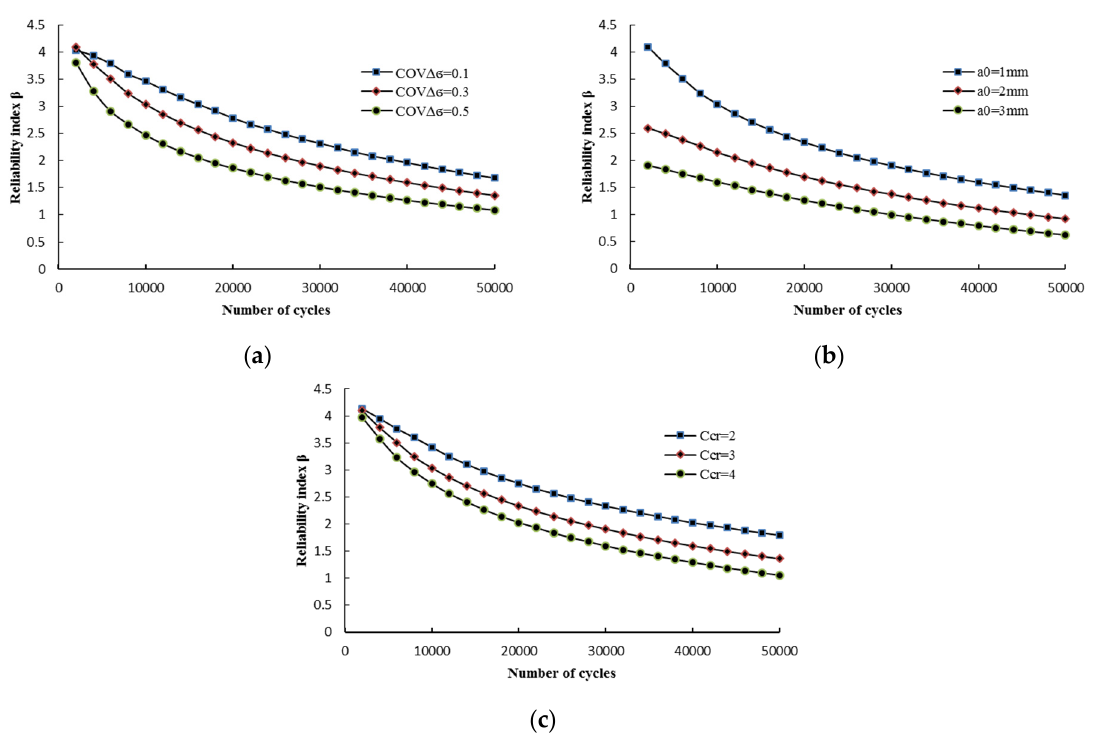
Figure 8. Effect of ( a ) uncertainty of stress range ( b ) initial crack size ( c ) mean value of corrosion enhanced parameter on reliability assessment of investigated pipeline.